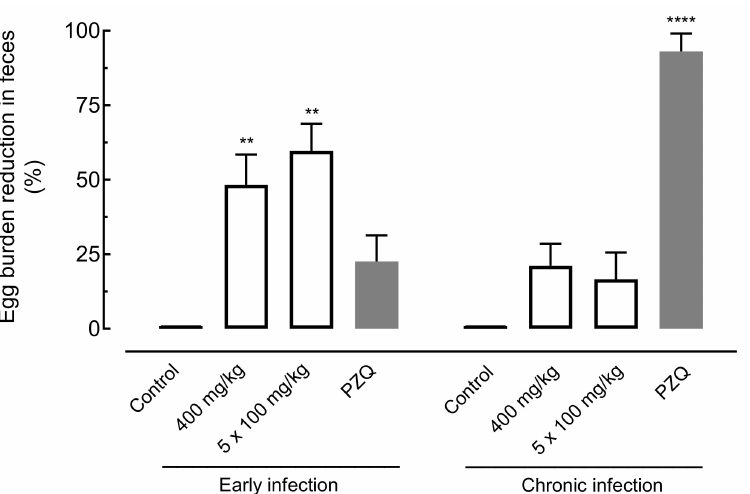
Figure 6. Effect of amiodarone on the egg burden in the tissue of mice harboring either early or chronic S. mansoni infection. Amiodarone (single dose of 400 mg/kg or 100 mg/kg for five consecutive days), praziquantel (PZQ, 400 mg/kg), and vehicle (control) were administered 21 days (early infection) or 49 days (chronic infection) post-infection by oral gavage. On day 63 post-infection, all animals were euthanized, and egg burdens were determined by counting immature eggs in the intestine. Points represent data from individual animals ( n = 5 per group). Horizontal bars represent median